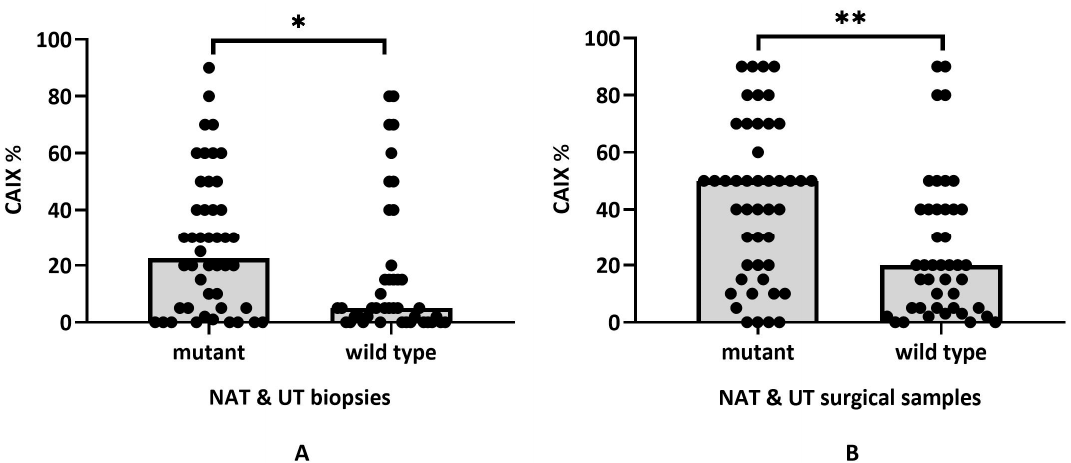
Figure 8. KRAS status and CAIX expression in combined NAT and UT rectal adenocarcinoma samples ( n = 89). Distribution of CAIX scores in KRAS mutant and wild-type tumors in biopsies ( A ) and surgical resection samples ( B ) Mutant KRAS tumors present with significantly higher overall CAIX scores (* p = 0.0138; ** p = 0.002).